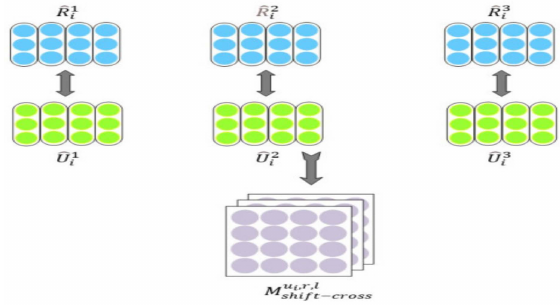
Figure 5. Shifted cross-attention matching